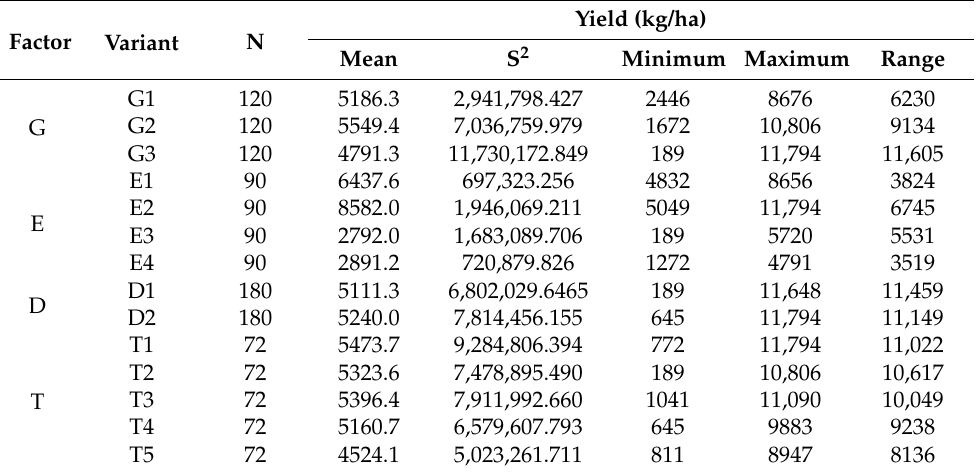
Table 5. Descriptive statistics for the genotype, the year–location interaction, crop density and the defoliation